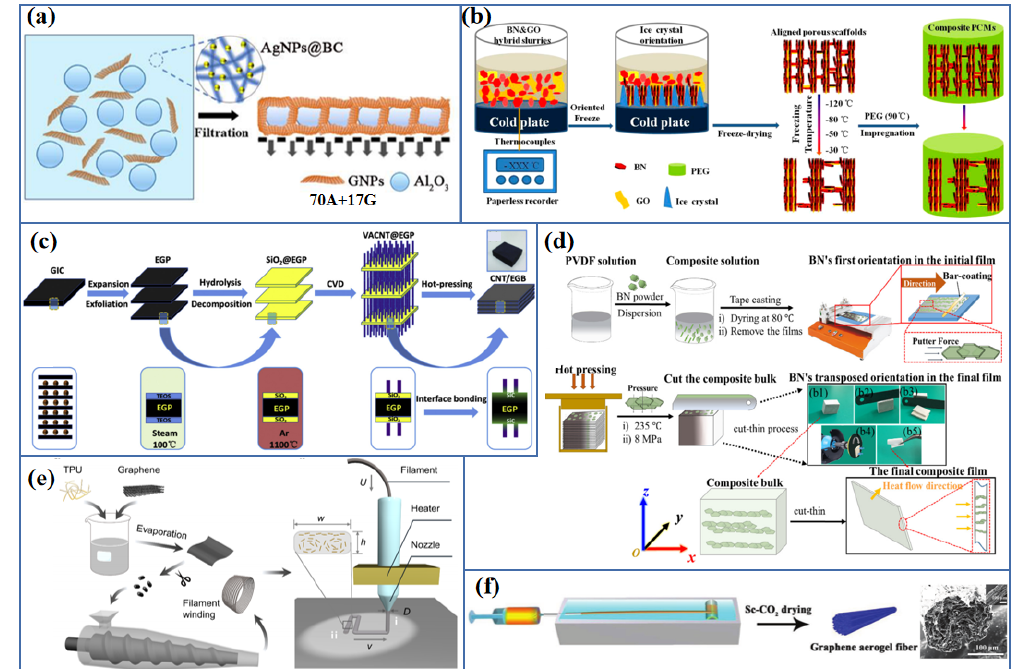
Figure 6. Illustration of approaches to construct an interconnected network of fillers by ( a ) vacuum-assisted layer-by- layer self-assembly strategy [47] (Copyright (2020) with permission from Elsevier B.V.), ( b ) ice-templating self-assembly strategy [84] (Copyright (2018) with permission from American Chemical Society), ( c ) CVD [85] (Copyright (2016) with permission from Elsevier Ltd.), ( d ) mold pressing [80] (Copyright (2019) with permission from Elsevier Ltd.), ( e ) 3D printing [86] (Copyright (2021) with permission from American Chemical Society) and ( f ) electrospinning [79] (Copyright (2018) with permission from Wiley Periodicals,